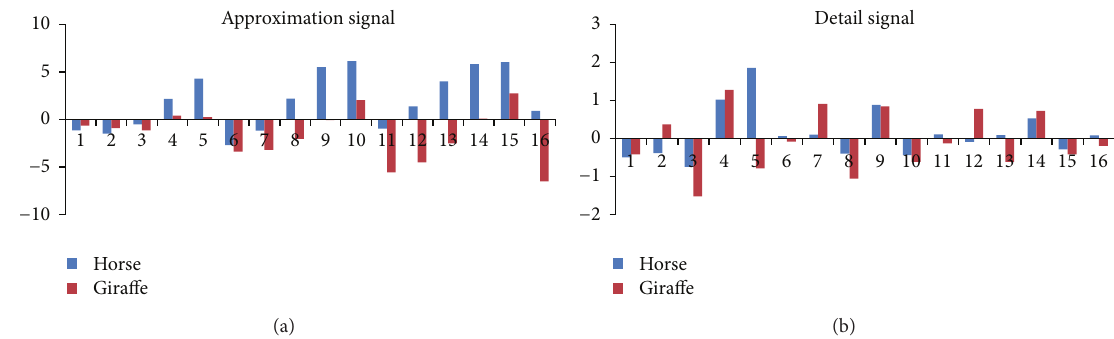
Figure 11: The first16MWD of the approximation and detail signal for “Horse” and “Giraffe.”